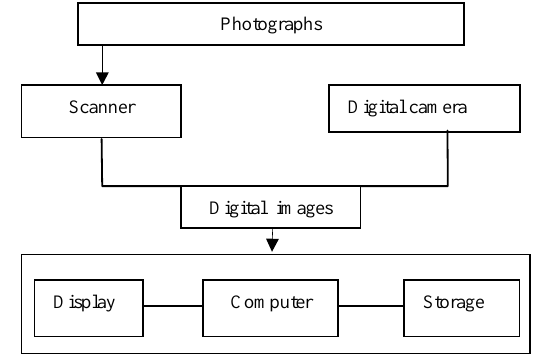
Fig 1. Schematic diagram of digital photogrammetric